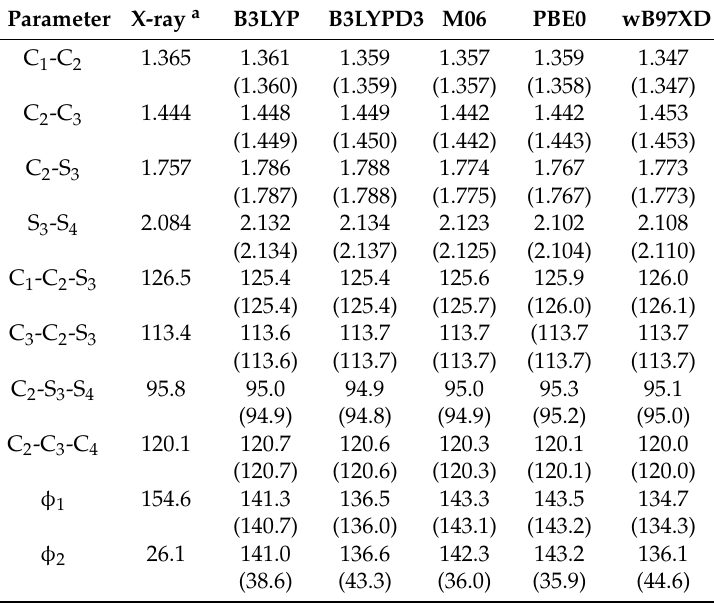
Table 1. Main structural parameters for the two minima a and b , intercepted along the potential energy surface scan of φ 2 dihedral angle in compound 1 , obtained employing different exchange–correlation functionals in dichloromethane environment. Distances are in Å. Valence and torsional angles are in degrees. Values for the relative minimum a are in